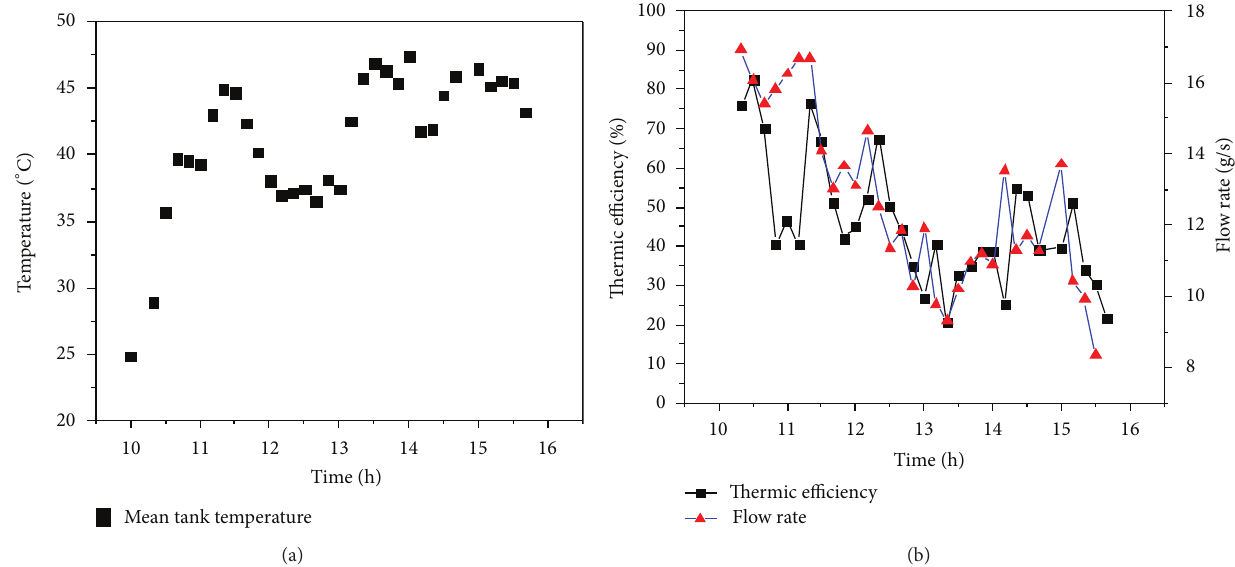
Figure 7: Hot water tank temperature (a) and calculated thermal efficiency of the system and the flow rate in the thermosiphon (b).